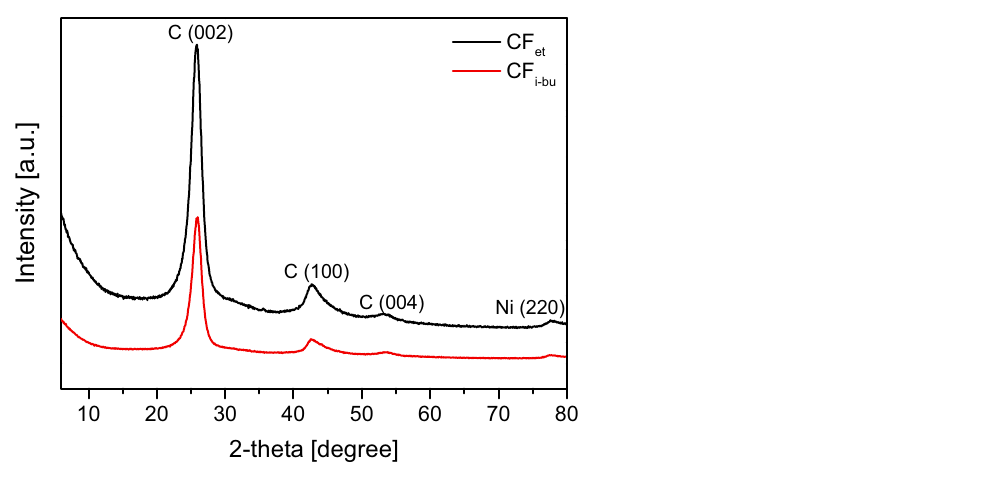
Figure 2. TEM micrographs of ( A ) CF i-bu and ( B ) CF et .